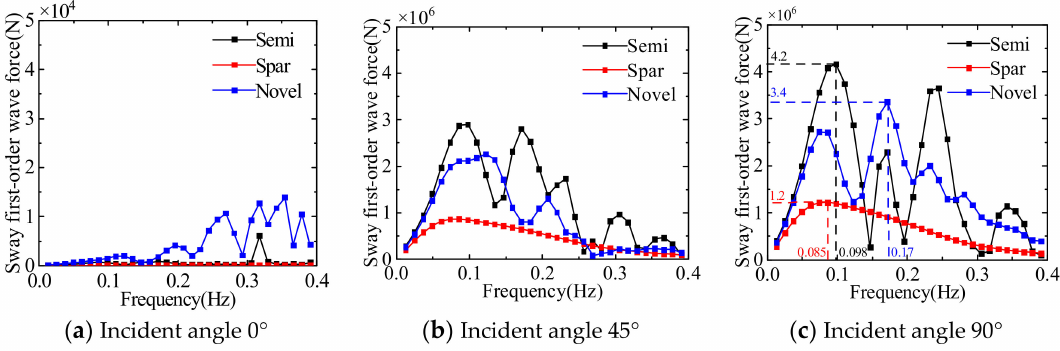
Figure 12. Comparison of the first-order wave force in sway direction of three floating platforms.